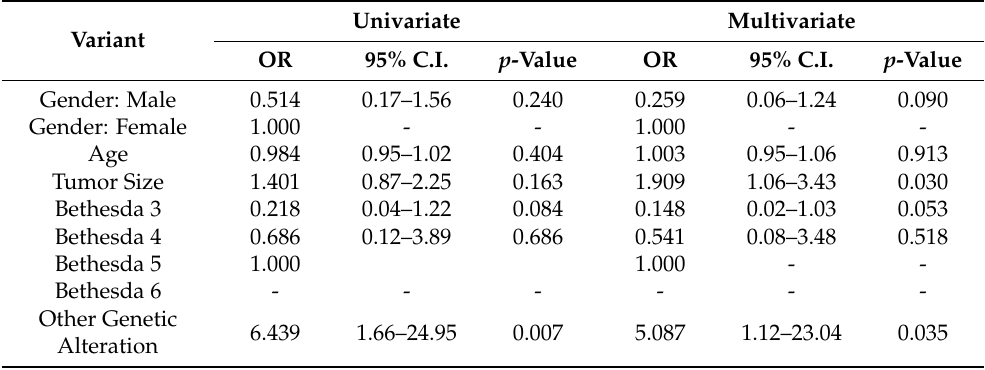
Table 4. Logistic regression results to predict the chance of malignancy using clinicopathological characteristics in the 67 patients with CNA-positive thyroid nodules that underwent surgery.